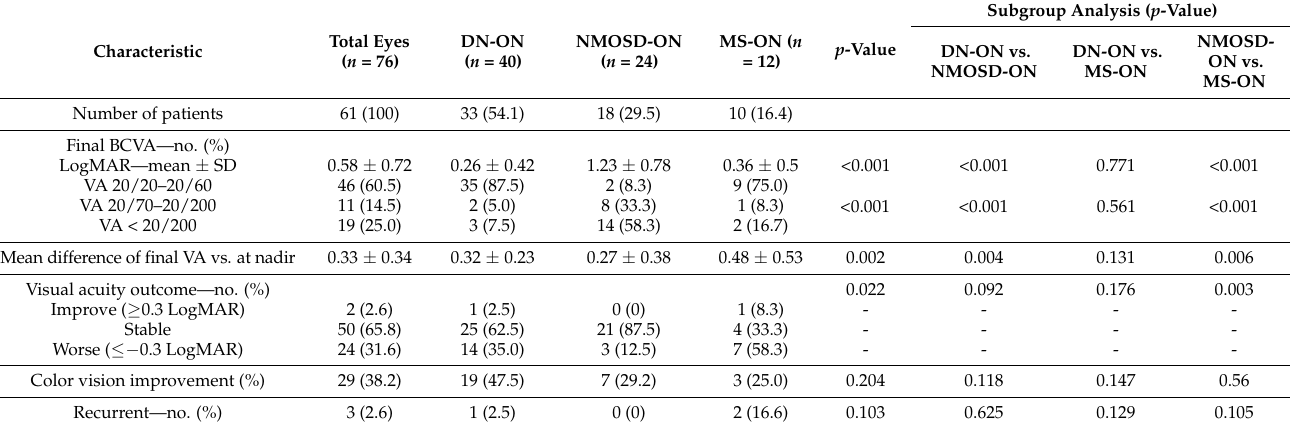
Table 3. Treatment outcomes of DN-ON, NMOSD-ON, and MS-ON of each affected eye (12 months).